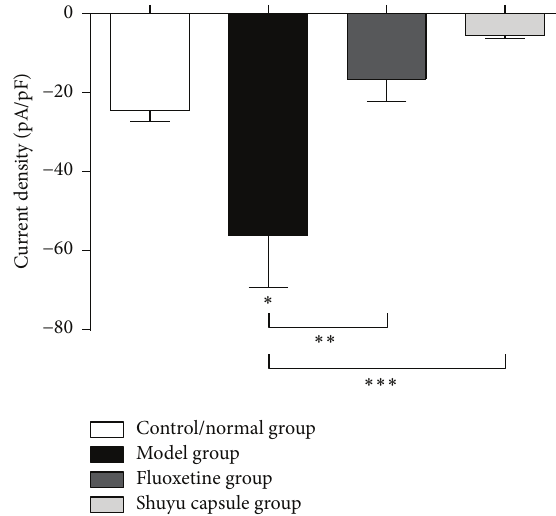
Figure 5: Whole-cell patch clamp analysis of primary hippocampal neurons. In this assay, 5-HT 3 R currents were recorded and analyzed for the following groups: the control/normal group (white), model group(black),positive-controlfluoxetinegroup(charcoalgray),and Shuyu capsule group (gray). 𝑛 = 6 , ∗ 𝑃 < 0.05 , ∗∗ 𝑃 < 0.01 , and ∗∗∗ 𝑃 < 0.001